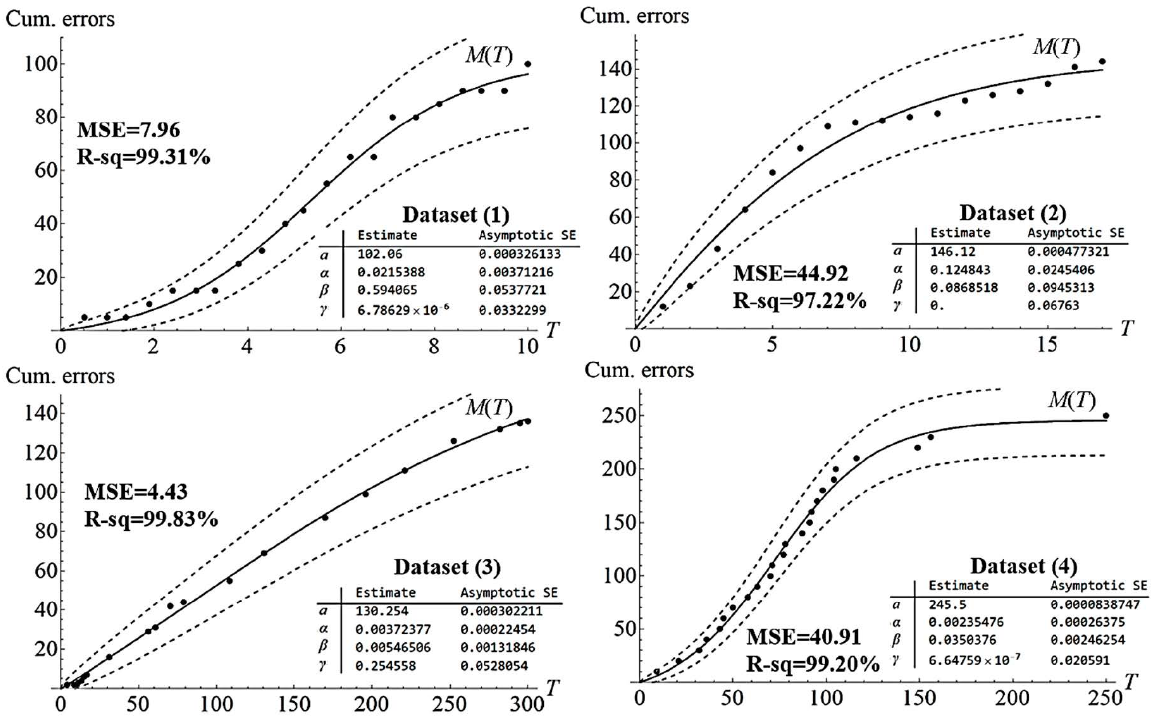
Figure 5. The fitting results and parameters estimation for the Proposed model.